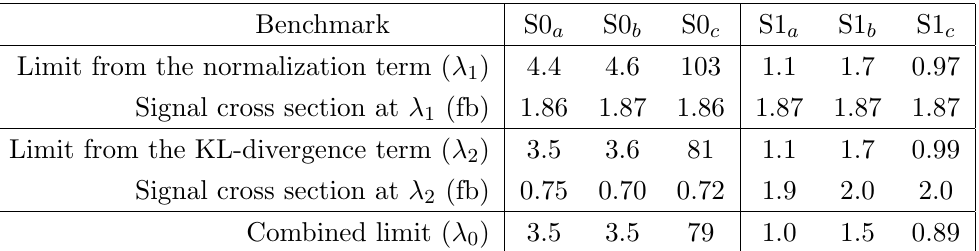
Table 6 . Upper limits on the coupling strength parameters of the dark sector models at 95% CL, with signal cross sections at the limit